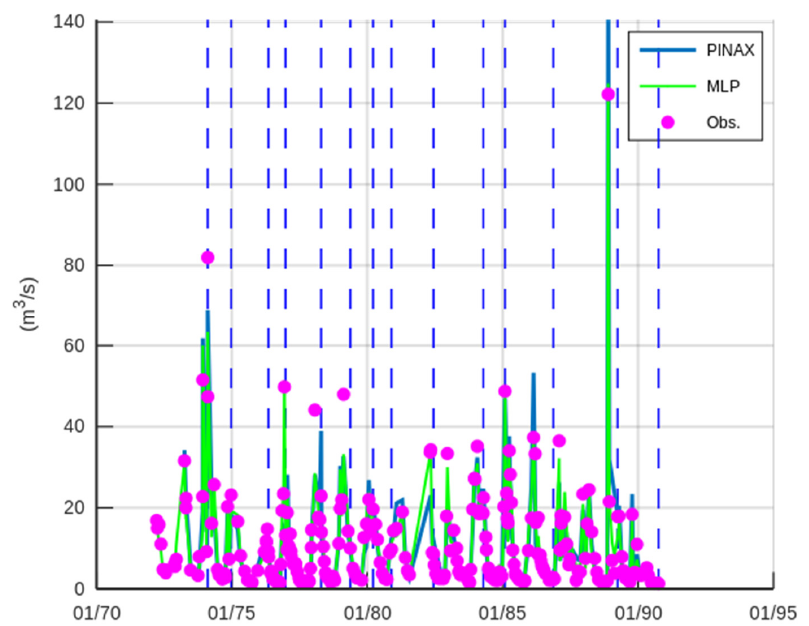
Figure 9. Trikeriotis case study—discharge calculated with the MLP and discharge calculated with the 14 PINAX-obtained regressions. The start and end of these 14 periods are marked with the dashed vertical lines.